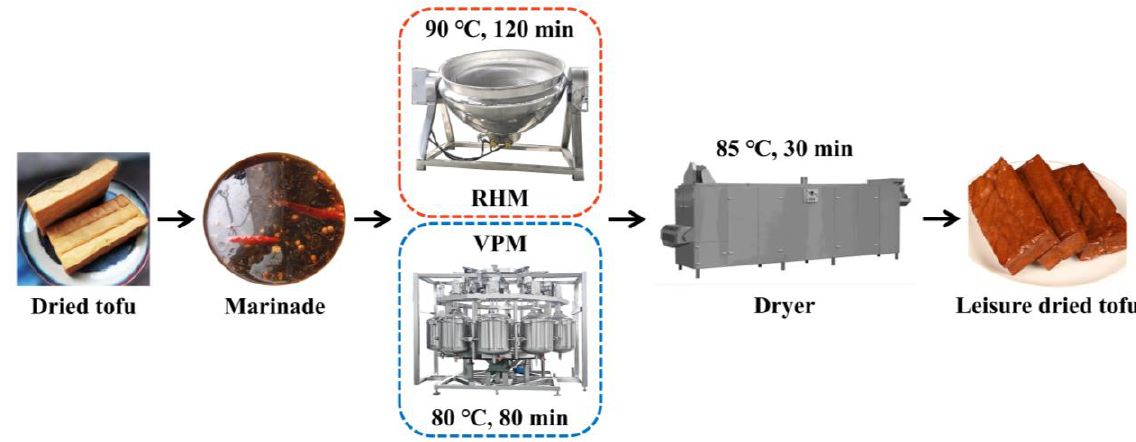
Figure 1. Marinating process flow chart of LD-tofu by RHM and VPM.